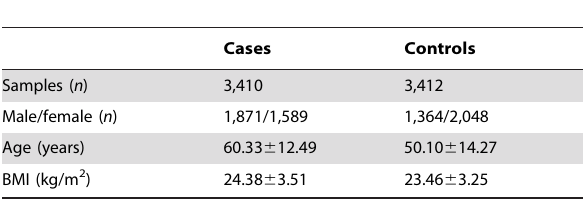
Table 1. Clinical characteristics of the study